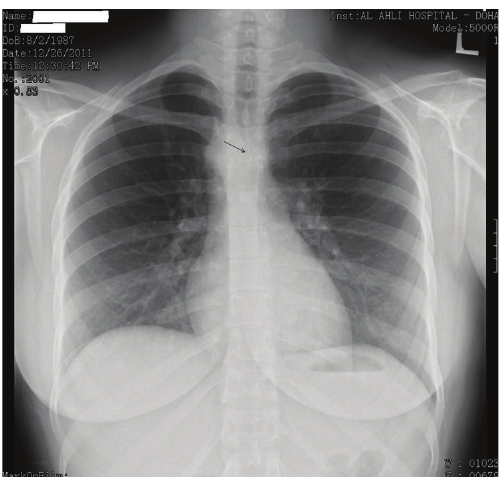
Figure 1: A posteroanterior view of chest X-ray showing an abnormal distal tracheal air shadow (arrow) and the absent left aortic knuckle.